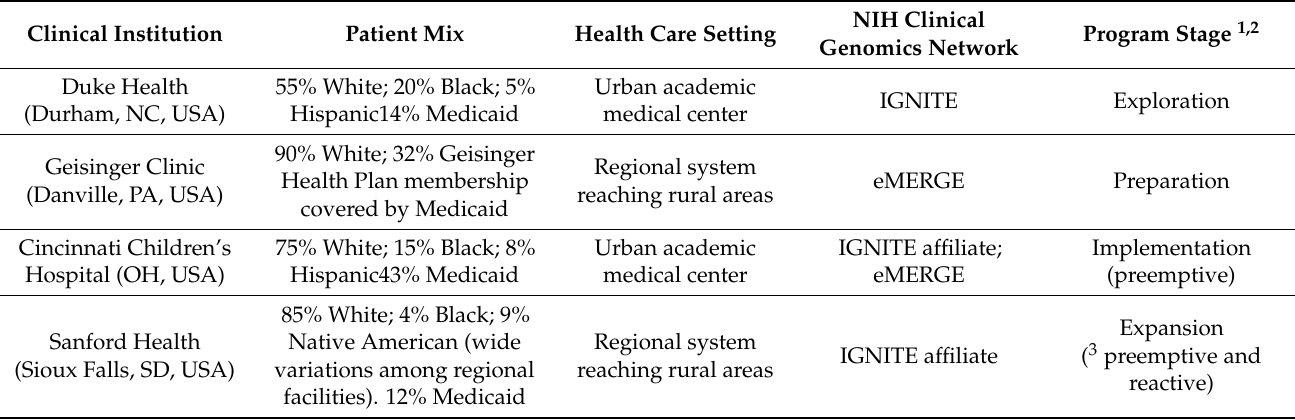
Table 1. Description of clinical